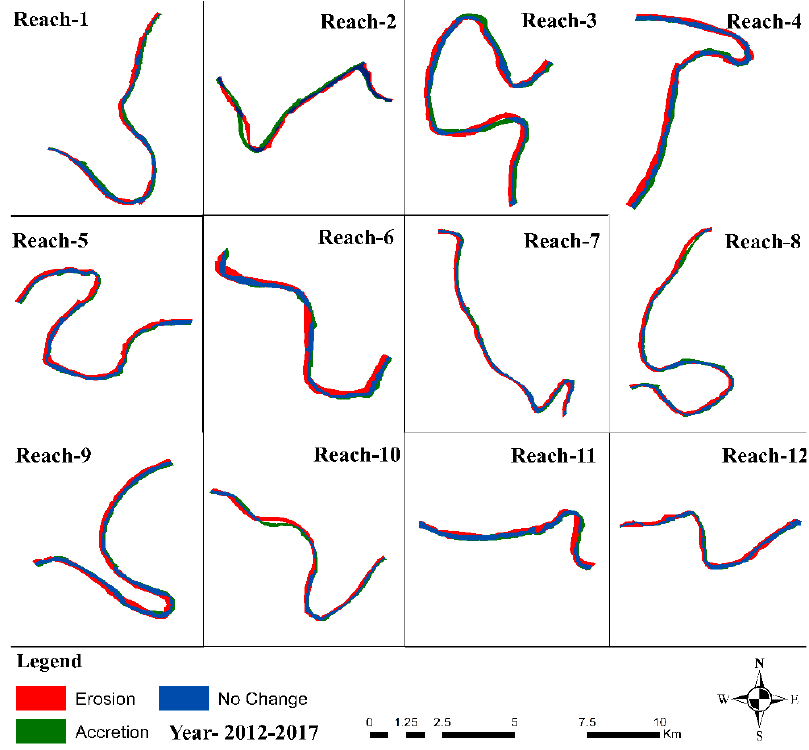
Figure 10. Erosion, accretion, and unchanged area at various reaches (1–12) between 2002–2012.